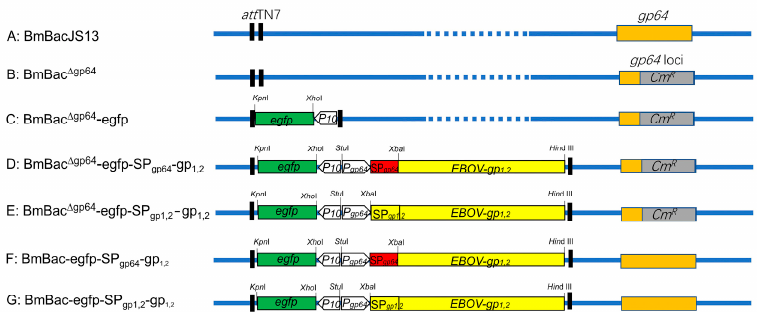
Figure 1. Schematic diagram of recombinant bacmid construction. The gp64 gene (khaki boxes) in wild type bacmid ( A ) was replaced by chloramphenicol resistance gene (CmR) ( B , grey boxes). Ebola virus (EBOV)-gp 1,2 (yellow boxes) linked to the GP64 signal peptide (red box) or the native signal peptide was driven by the gp64 promoter and placed between the indicated restriction sites, and were transposed into BmBacJS13 ( A ) or BmBac ∆ gp64 ( B ) to generate recombinant bacmids BmBac ∆ gp64 -egfp-SP gp64 -gp 1,2 ( D ), BmBac ∆ gp64 -egfp-SP gp1,2 -gp 1,2 ( E ), BmBac-egfp-SP gp64 -gp 1,2 ( F ), BmBac-egfp-SP gp1,2 -gp 1,2 ( G ), egfp was transposed into gp64 null bacmid to generate BmBac ∆ gp64 -egfp ( C ). The genomes of the BmNPV bacmids are represented by blue lines.